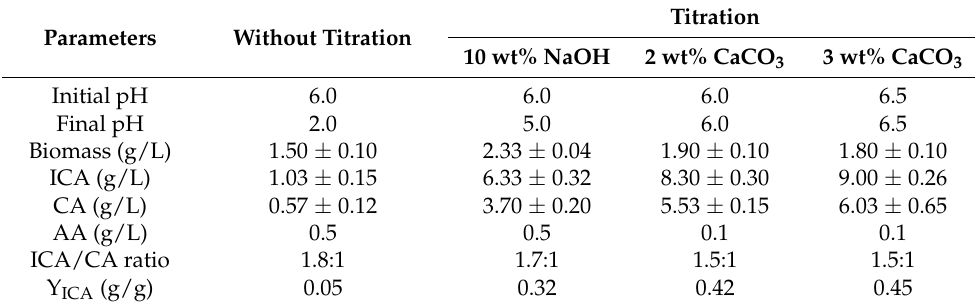
Table 4. Effect of medium titration on Y. lipolytica VKM Y-2373 growth and ICA production.